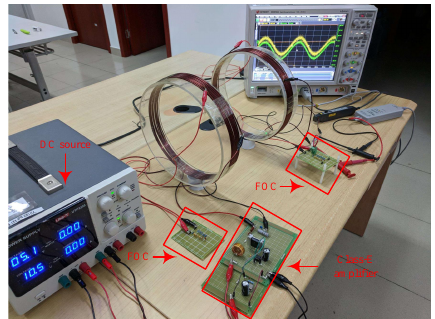
Figure 12. Experimental prototype of the FO-WPT.